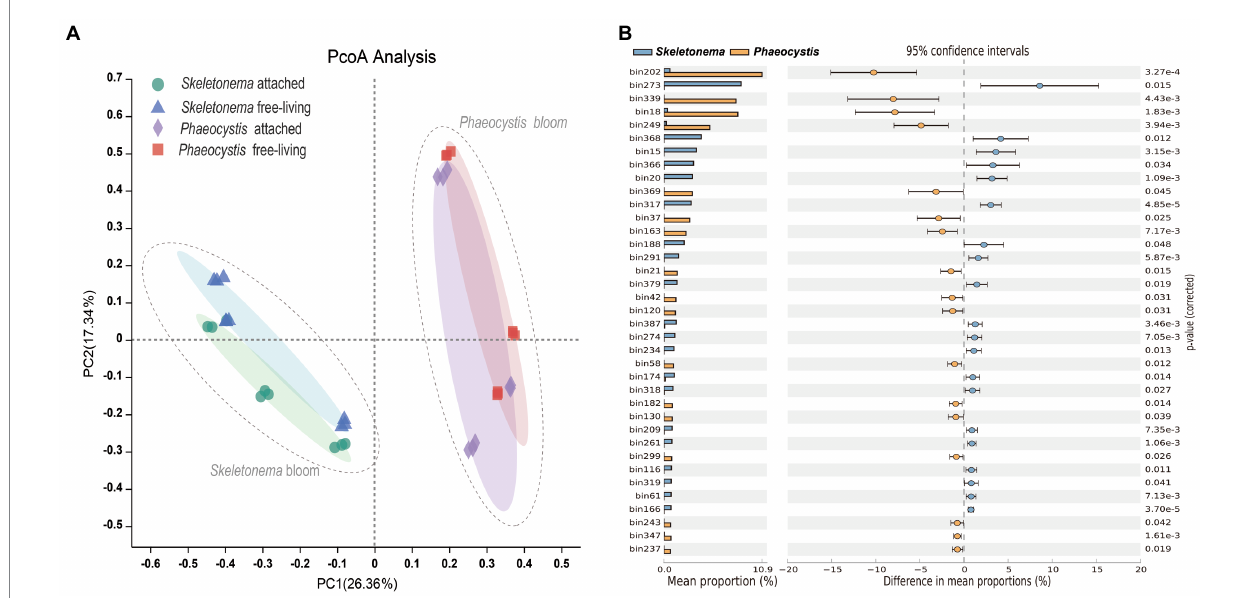
FIGURE 4 Microbial community composition during bloom succession. (A) PCoA plot based on the Bray-Curtis distance for bacterial community composition during the bloom process. (B) Differentially abundant MAGs between the Skeletonema sp. and Phaeocystis sp. blooms using the STAMP software. The p value was tested by Student’s t -test and corrected using the Bonferroni